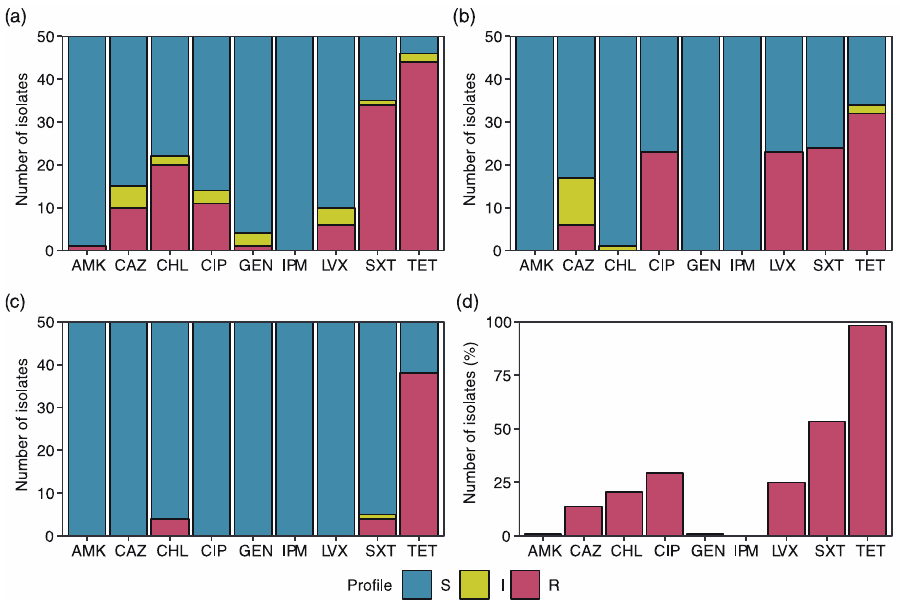
Figure 1. E. coli antibiotic resistance profile in ( a ) Ciudad del Niño, ( b ) Escobal, ( c ) El Arado: S indicates sensitivity to the antibiotic (in blue), I indicates intermediate sensitivity (in yellow) and R indicates resistance (in red). ( d ) Shows the whole percentage of resistant strains to each of the antibi- otics analyzed. AMK: amikacin; CAZ: ceftazidime; CHL: chloramphenicol; CIP: ciprofloxacin; GEN: gentamicin; IPM: imipenem; LVX: levofloxacin; SXT: trimetropin/sulfamethoxazole; TET: tetracycline. Resistance to gentamicin and amikacin (2%) was only present in Ciudad del Niño 91 (Figure 1a). Levofloxacin and ciprofloxacin prevalence was the highest in Escobal (46% 92 each; Figure 1b). In El Arado, only tetracycline (76%), trimetropin- sulfamethoxazole (8%), 93 and chloramphenicol (8%) resistant strains were detected (Figure 1c). 94 Among all the isolates that exhibited resistance to at least one antibiotic, 98.28% of 95 them were resistant to tetracycline, followed by trimetropin- sulfamethoxazole (53.45%), 96 ciprofloxacin (29.31%) and levofloxacin (25%). Resistance to imipenem was not detected 97 in any of the E. coli isolates analyzed (Figure 1d). 98